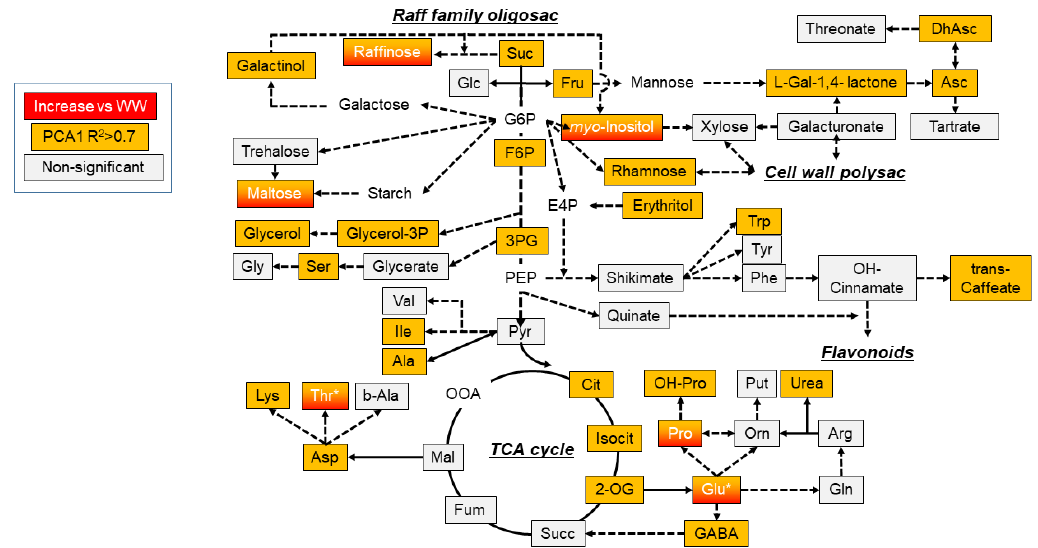
Figure 3. Common changes in leaf primary metabolism under water deficit stress (WDS) in all cultivars. Metabolites colored are those showing statistically significant ( p < 0.05) increases in all cultivars (red) under WDS, and with a r 2 > 0.7 associated to the principal component 1 (orange). Data used was taken from Figure 1 and Table S4. Suc, sucrose; Glc, glucose; Fru, fructose; G6P, glucose-6-phosphate;